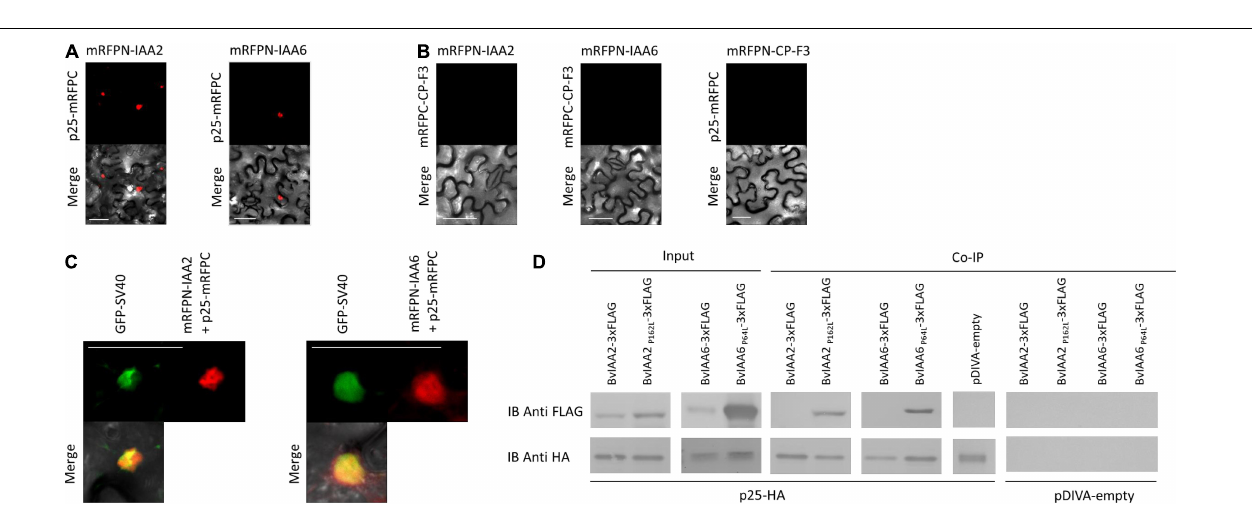
FIGURE 2 | Results from YTH experiment with all Aux/IAA proteins from sugar beet and BNYVV p25. The positive control AD-p53 with BD-LTA and the negative control AD(-empty) with BD(-empty) were supplied by MoBiTech. BNYVV p25 was fused to the BD and the IAAs to the AD to test for interaction. Yeast transformants, containing both plasmids were selected on DOBA Glu (-H, -W), single colonies were resuspended in water and diluted 1 × 10 − 1 - 1 × 10 − 4 . 5 µ l of each dilution was spotted on the control medium [DOBA Glu (-H, -W)] and selection medium [DOBA Gal/Raf (-H, -W, -L)], only the 1 × 10 − 2 dilution is shown here. An AD or BD without any fusion proteins and transformed with BD-p25 or AD-Aux/IAA, respectively, served as control for autoactivation. AD, activating domain; BD, binding domain; DOBA, Dropout Base Agar.